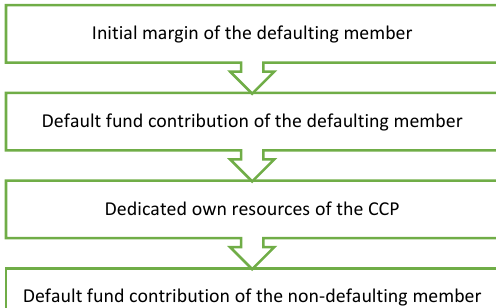
Figure 1. Default waterfall.